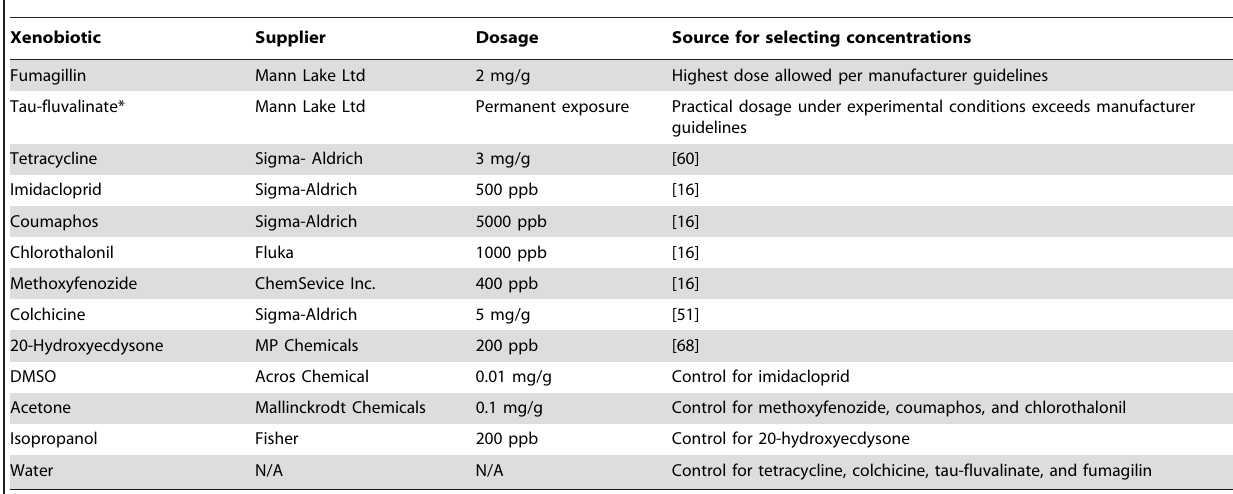
Table 1. Xenobiotics tested in the first experiment for effects on the intestinal stem cell proliferation.